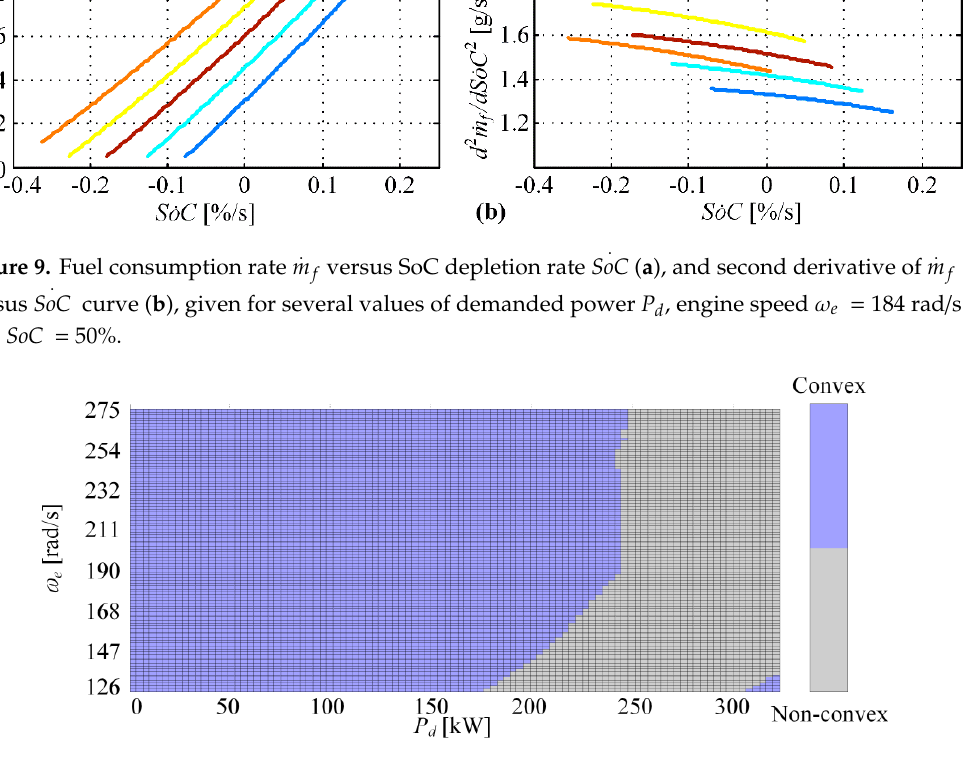
speeds 𝜔 𝑒 and driver power demands 𝑃 𝑑 for the case of 𝑆𝑜𝐶 = 0.5.